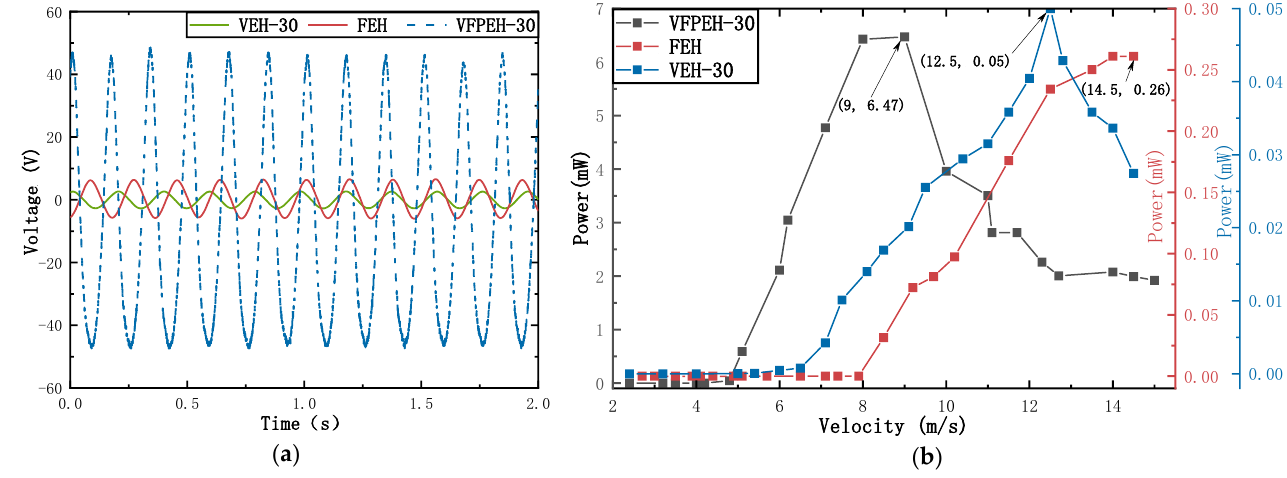
Figure 13. Output characteristics of three energy harvesters: ( a ) Output voltage; ( b ) Output power.